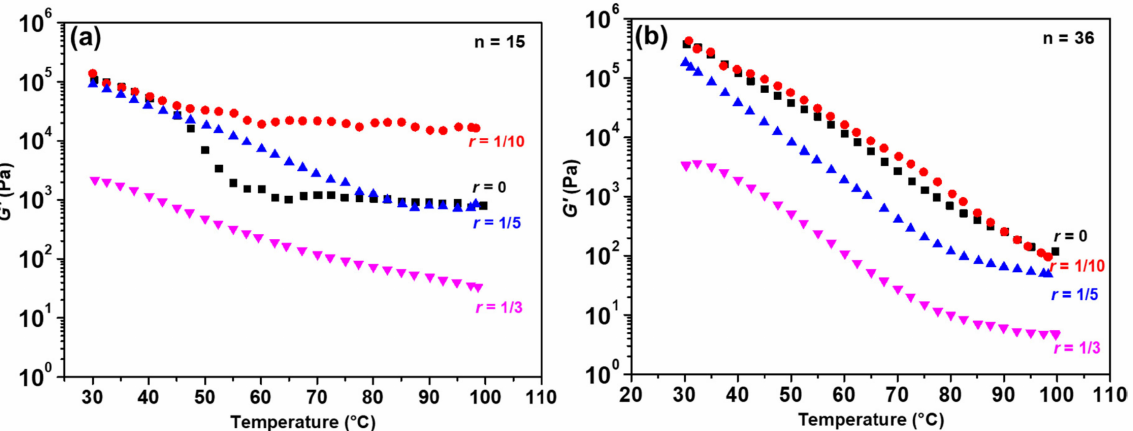
Figure 3. Storage moduli ( G’ ) of the PEO 114 - b -PDM n -dTFSI/LiTFSI electrolytes with different doping ratios upon heating when ( a ) n =15 and ( b )